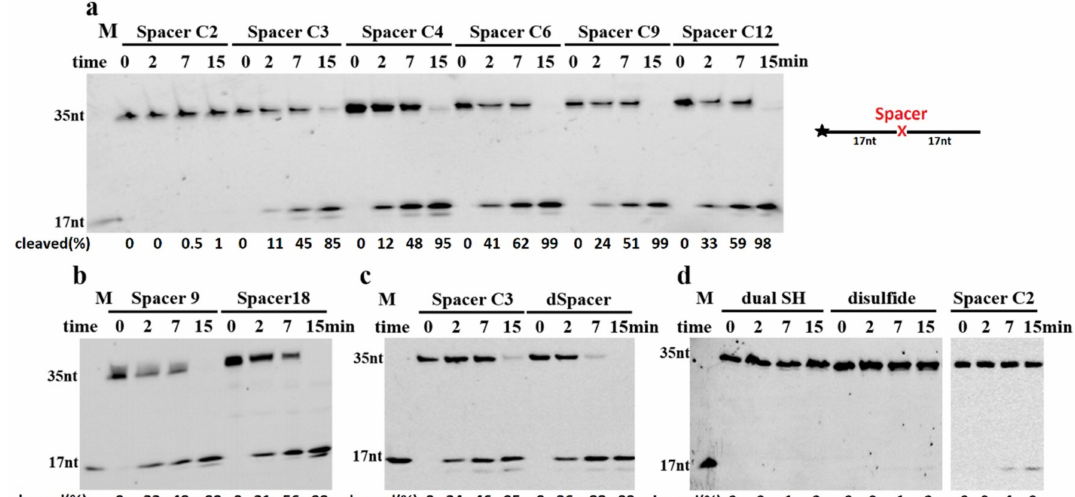
Figure 3. AP endonuclease activity on ssDNAs containing various Spacers. Different ssDNAs (100 nM) containing ( a ) alkane spacers, ( b ) polyethylene glycol spacers, ( c ) dSpacer and spacer C3, and ( d ) sulfur atom spacers were incubated with 5 nM ( a – c ) or 10 nM (d) of TeuendoIV at 55 ◦ C for the indicated time. For the Spacer disulfide bond (S-S), the NAD + (1.0 mM) was substituted for DTT in the reaction buffer. Uppercase letter M denotes oligonucleotides marker. The cleavage percentages of substrates are listed at the bottom of each panel. The symbol of black asterisk and the red letter X denote the fluorescein (6-FAM) group at the 5 (cid:48) -end and the AP-sites,